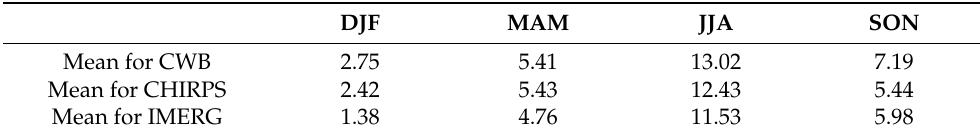
Table 4. Seasonal mean precipitation (unit: mm · d − 1 ) averaged during 2001–2019, and area-averaged over Taiwan, for individual